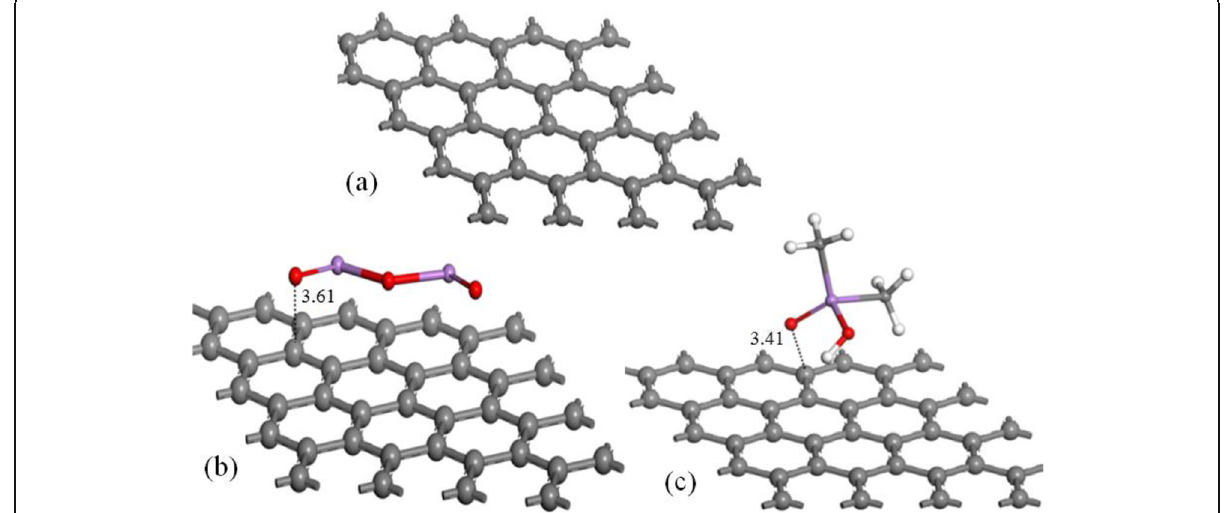
Fig. 8 Configurations of As (III) and DMA adsorption on SBC